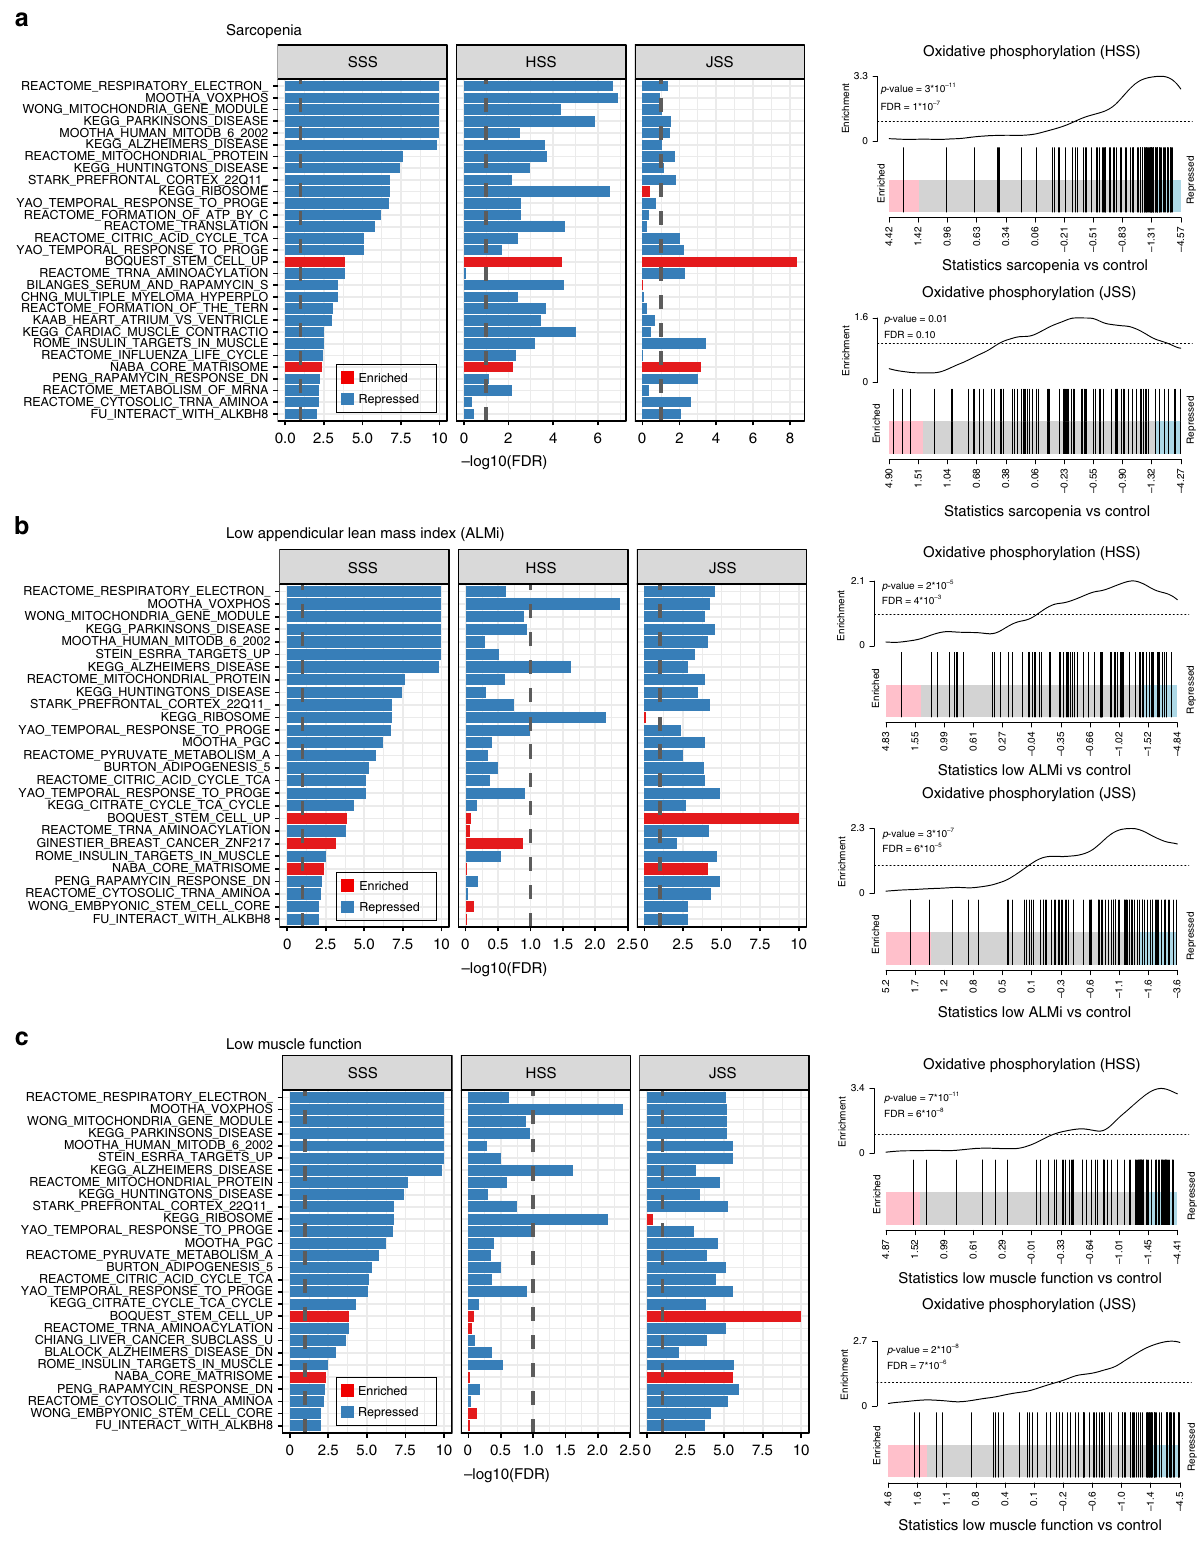
continuous variables (Fig. 4a). The expression of 318 genes encoding 276 proteins and 42 noncoding RNAs were associated with ALMi at FDR < 10%. In contrast, muscle gene expression associations with grip strength and gait speed were weaker with only 7 and 9 genes, respectively, associated at a nominal p value < 0.001 but FDR > 10%. A large number of genes regulated in